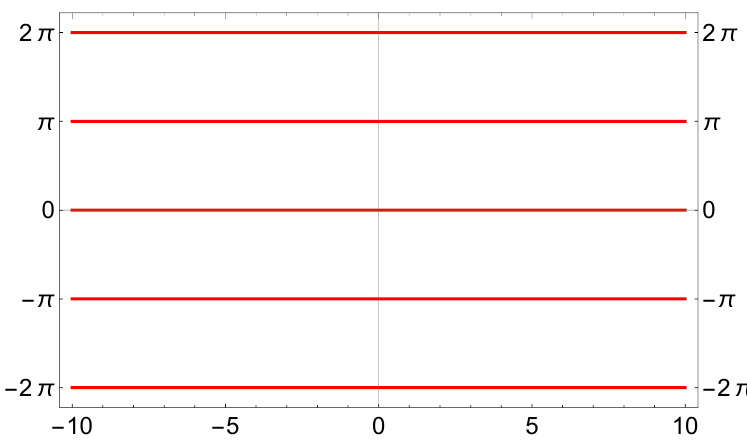
Figure 9 . Stokes diagram for P ( x ) = e 2 x , which corresponds to SU(2) 0 trivial theory. There are infinite number of special WKB lines depicted as red paralell